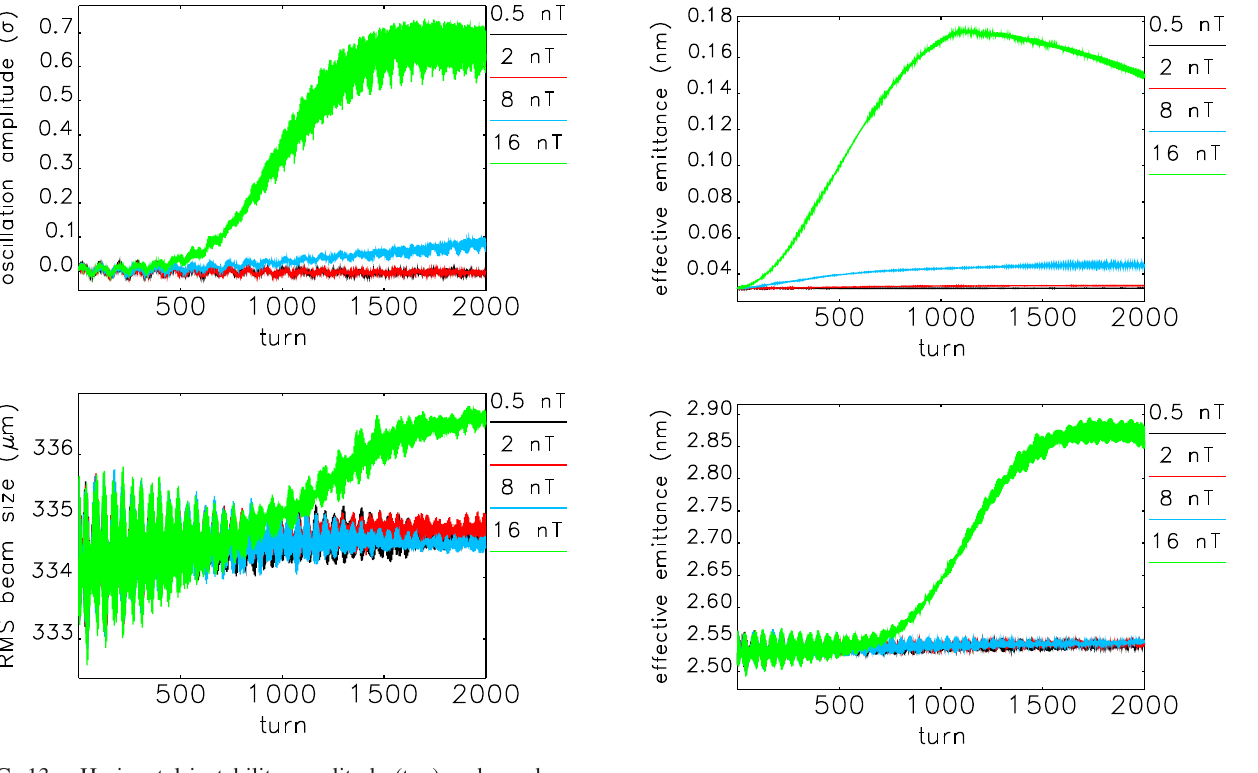
FIG. 14. Effective emittance in the vertical (top) and horizontal (bottom) planes, for different pressure